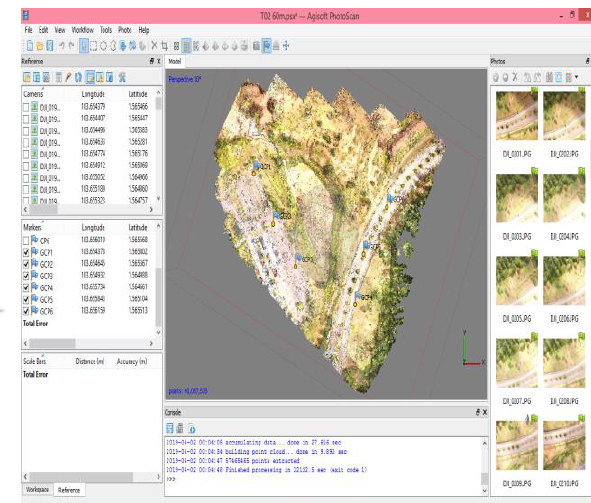
Figure 11. Agisoft Photoscan Professional Software during Image Processing